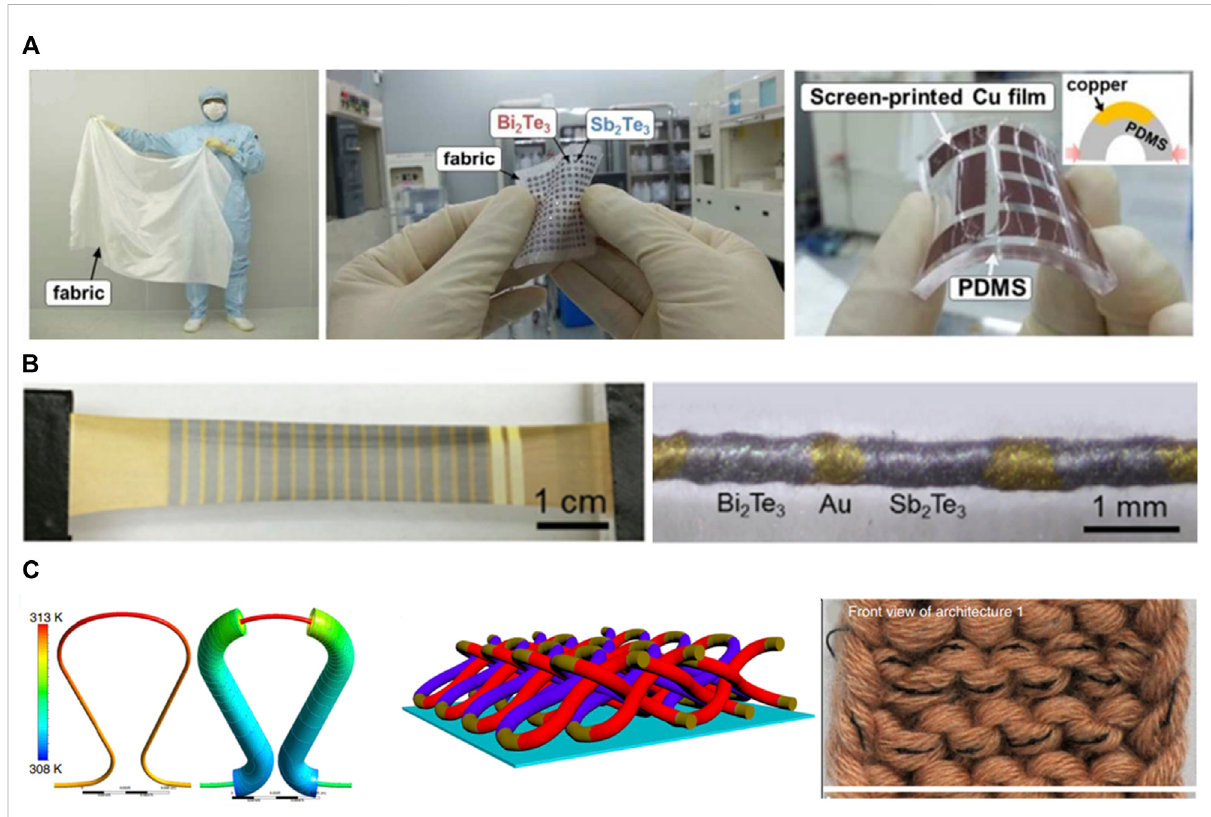
FIGURE 2 (A) Glass fabric, results of screen printing, fi lling with PDMS (Kim et al., 2014). (B) Showing of segmented thermoelectric-fabric product, using magnetron sputtering (Lee et al., 2016). (C) The architecture of the fabric (Sun et al.,